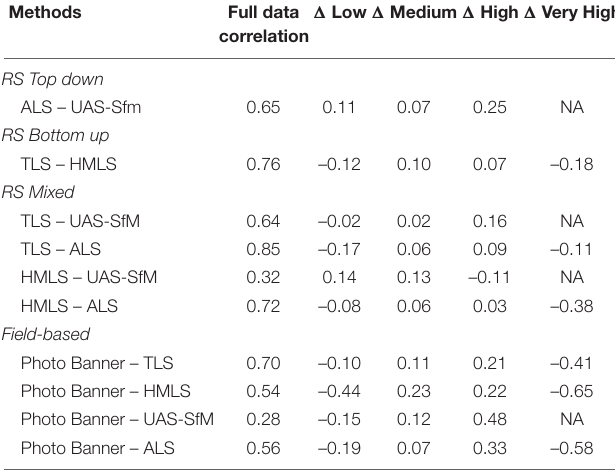
TABLE 4 | Differences ( (cid:49) ) between the Pearson correlation values of ladder fuel density from 1 to 4 m strata calculated without (full data) and with canopy base height (CBH) categories (low, medium, high and very high).